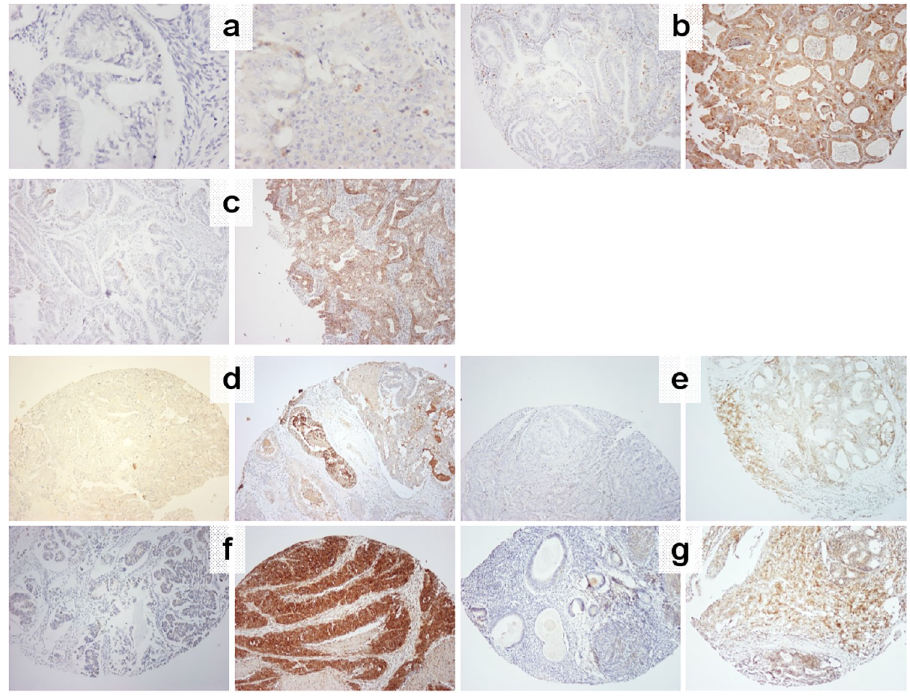
Fig 2. Characteristic examples of negative and positive protein markers with IHC. For all panels, negative is on the left, positive on the right. (a) Notch2, x400; (b) Notch3, x100; (c) Jag1, X100; (d) Gli, X100; (e) Patched-1, X100; (f) Shh, X100; (g) Smo,